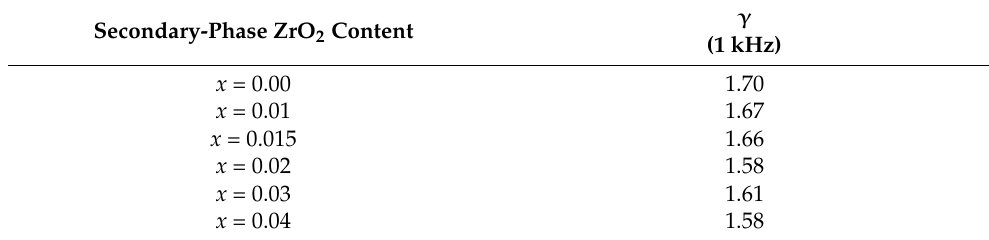
Table 2. Diffusion coefficients ( γ ) of PZTN ceramics sintered at 1260 ◦ C for 2 h. Secondary-Phase ZrO 2